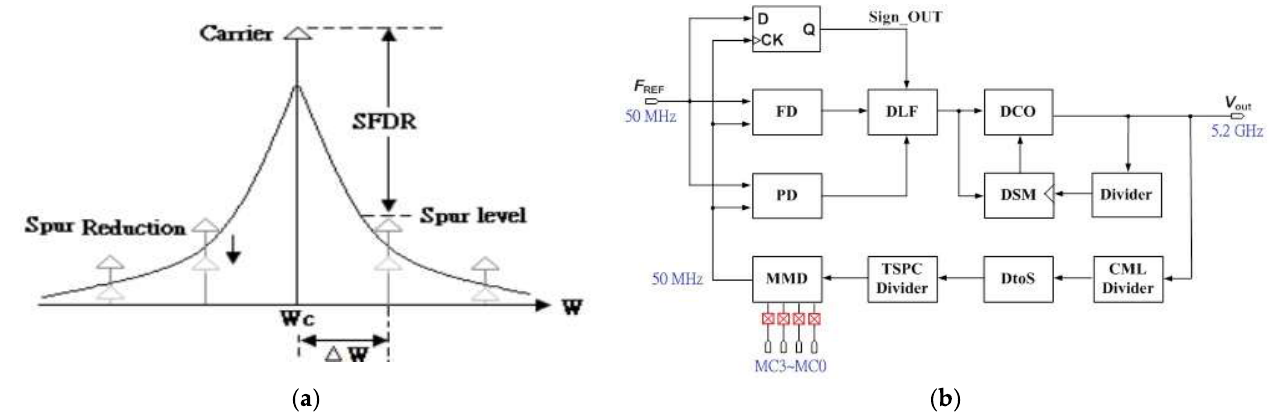
Figure 1. ( a ) Frequency domain representation of spurs; and ( b ) the function block of the introduced all-digital frequency